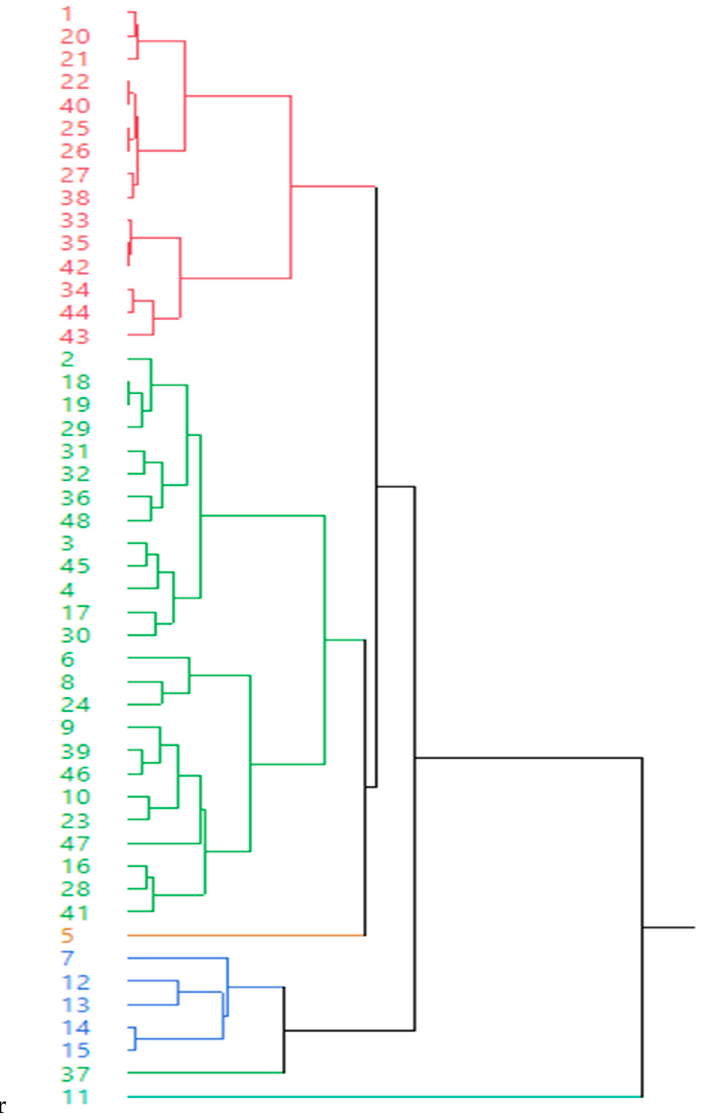
Figure 1. Dendrogram showing the results of 48 Pasteurella multocida isolates after a hierarchical clustering analysis of MIC values for the 12 antimicrobials tested.